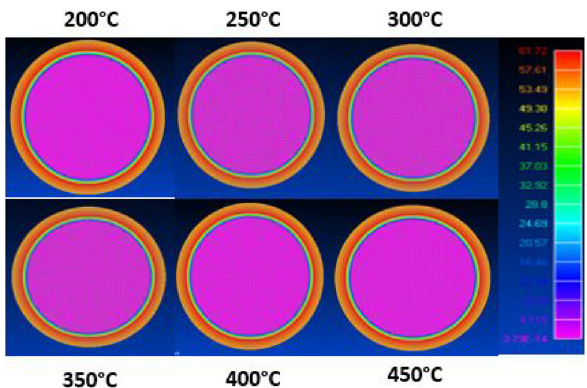
Fig. 7 Temperature gradient across the well at different steady-state thermal regimes (for the view of figures with labels and coordinates, a reader is advised to see Online Appendix A1)